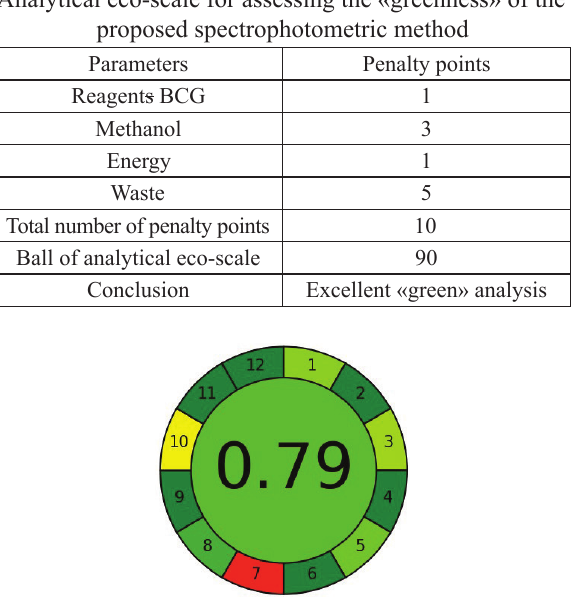
Fig. 6. Pictogram of an analytical method